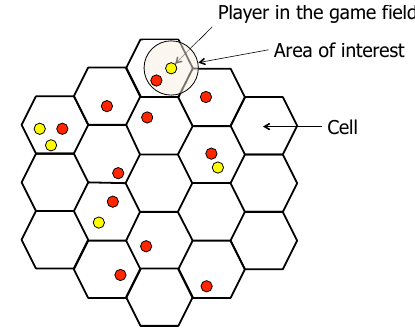
Fig. 2. Game field partitioned into hexagonal cells (yellow circle means a player corresponding to an ordinary peer and red circle means a player corresponding to a